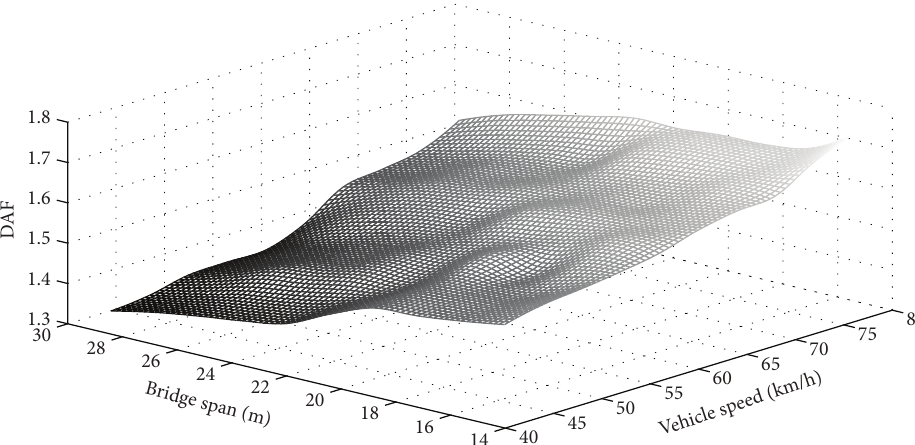
Figure 29: Dynamic amplification factor with change in bridge span and vehicle